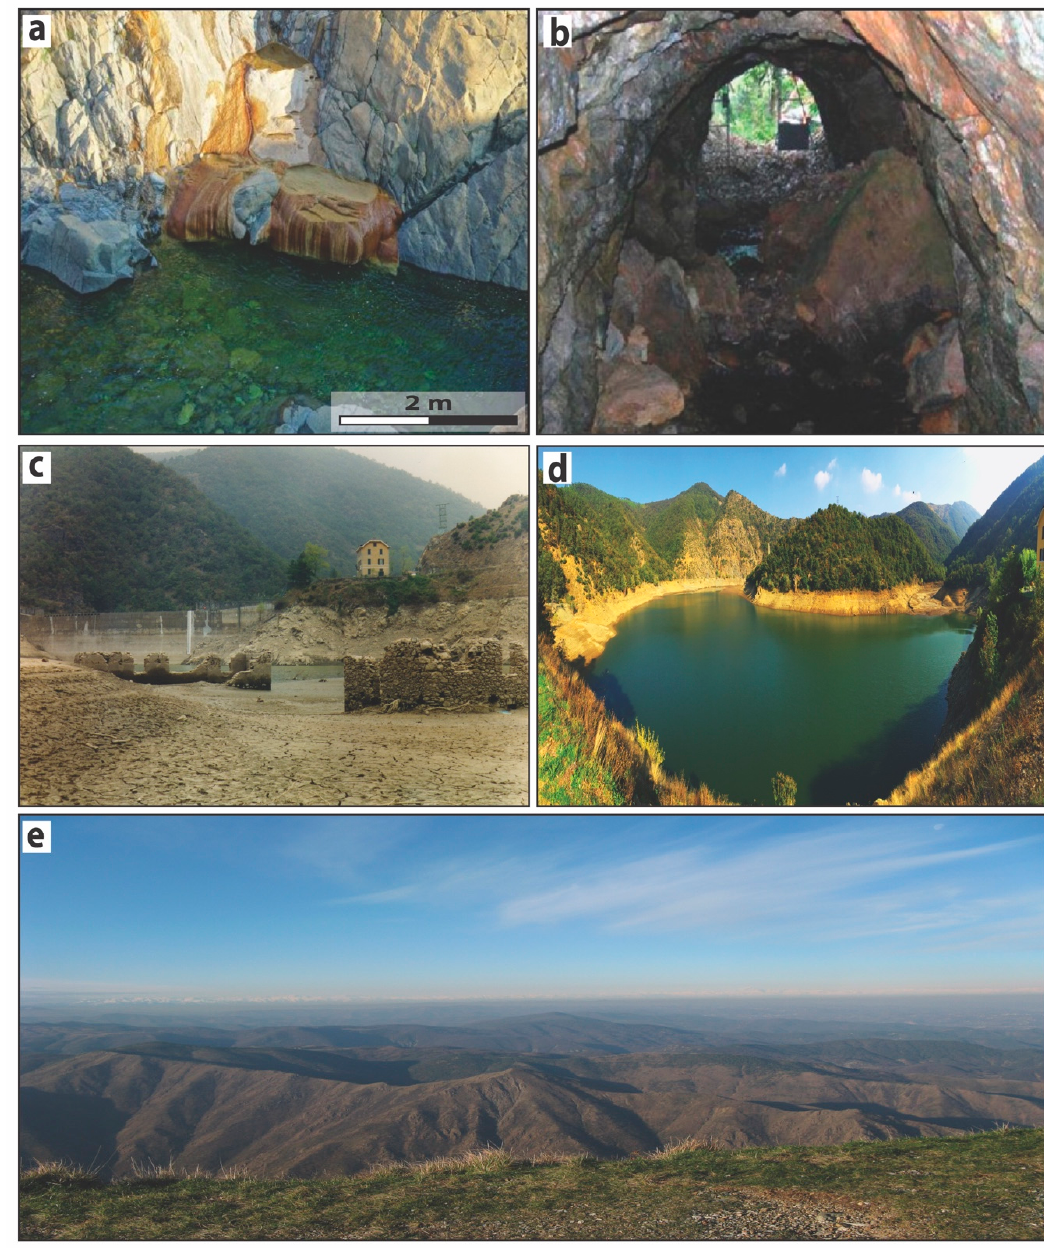
Figure 5. (Color online): ( a ) Alkaline spring; ( b ) One of the gold mine entrances to the galleries occurring in the area; ( c ) the ruins of the metallurgical plant is still visible at the bottom of the lake during periods of drought; ( d ) panoramic viewpoint of the lake from the trail that runs along it; ( e ) breathtaking panoramic view from the Tugello Mountain.